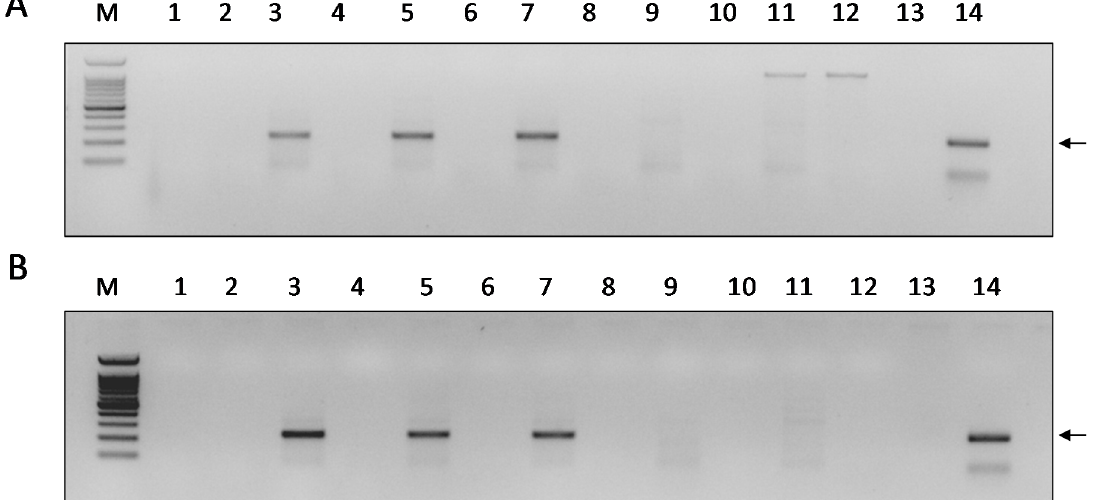
Figure 3. Detection of the DWV negative-sense RNA strand in infected P1-cells. Panels A and B , PCR from cells incubated for 15 and 30 min with DWV and subsequent wash of the viral inoculum, respectively. Lanes 1 and 2—Samples extracted at 15 and 30 min p.i. (Panels A and B, respectively). Lanes 3–4, 5–6, 7–8—Samples extracted at 18, 24, and 48 h. p.i., respectively. Lanes 9–10—samples extracted from heat-inactivated DWV-infection at 48 h p.i. Lanes 11–12—Extracts from mock-infected cells. Even numbers indicate a PCR control reaction from the same individual RNA performed on the cDNA produced without any primer (see the section Materials and Methods, Section 2.4). M—100 bp DNA Ladder RTU Marker (GeneDireX TM ), lower band 100 bp. Lane 13—NTC, non-template control, amplification of the positive sample without PCR primers. Lane 14, DWV amplicon (arrow).